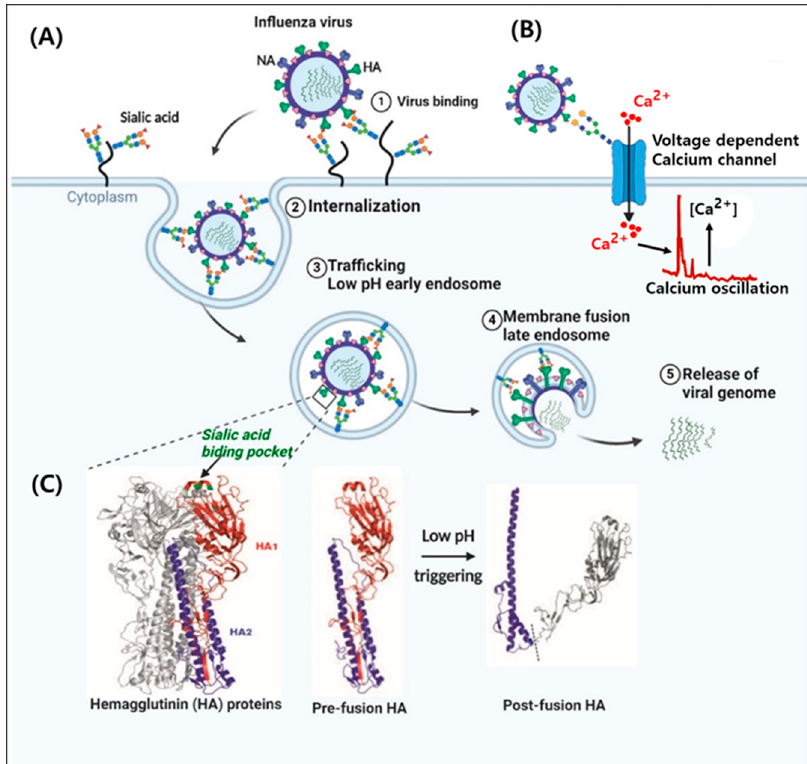
Figure 1. Influenza A virus endocytosis and hemagglutinin proteins (HA) conformational change. ( A ) Process of the entry of influenza virus into host cell. The virus binds to sialic acid-containing proteins on the cell surface receptors by association with the viral hemagglutinin proteins (HA1, HA2). HAs also bind to the sialic acid-containing Ca 2+ channel to trigger intracellular Ca 2+ oscillations. The virus is then internalized by endocytosis. Acidification of the endosome causes a conformational change in the HA proteins that leads to a fusion between the viral membrane and the endosomal membrane. This allows the escape of the viral RNA and proteins into the cytoplasm. ( B ) Structure of the HA of IAV. The trimeric complex of HA is shown with one monomer highlighted in color (HA1; red, HA2; blue, and the receptor binding pocket; green). ( C ) The pre- and post-fusion conformations of HA [4]. This figure was created using BioRender (Toronto, ON,